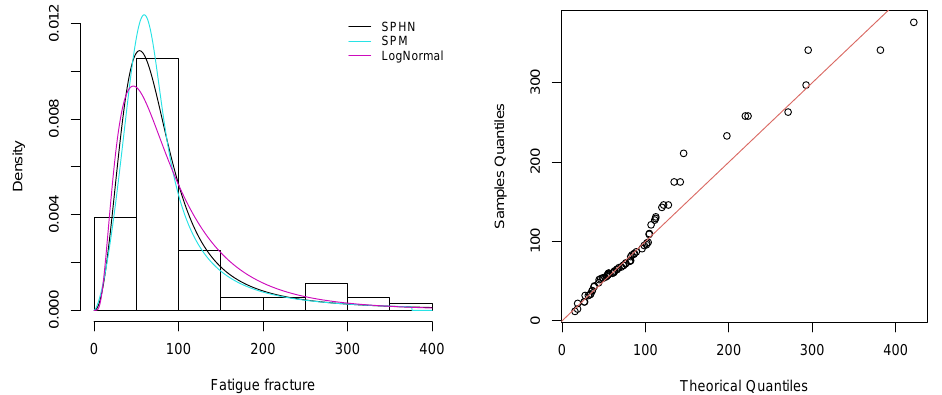
Figure 8. Left panel: Histograms of the survival times of guinea pigs data fitted by the LogNormal, SGHN and SPHN distributions. Right panel: QQ-plot of the SPHN